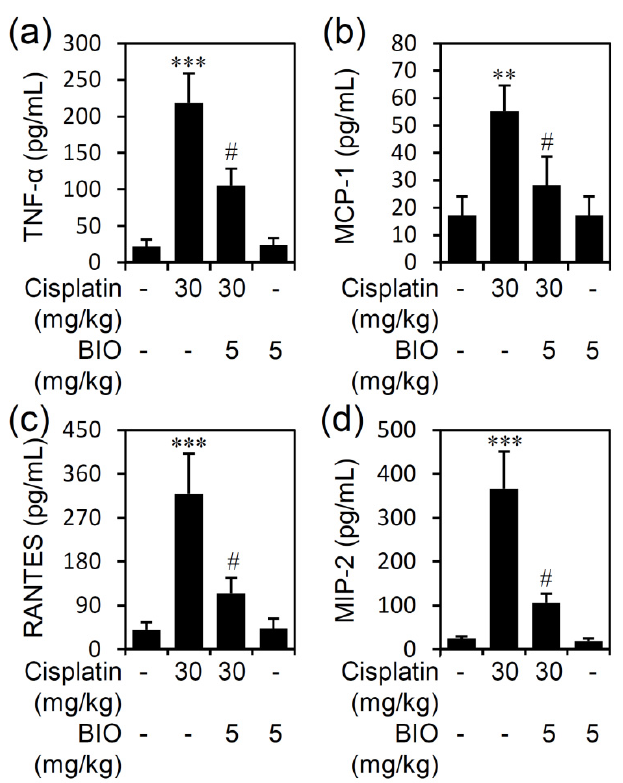
Figure 5. Inhibiting GSK-3 blocks cisplatin-induced proinflammatory cytokine/chemokine production. Male C57BL/6 mice ( n = 3) were preinjected i.p. with the GSK-3 inhibitor BIO (5 mg/kg) for 0.5 h followed by cisplatin (30 mg/kg) for 24 h. ELISA for ( a ) TNF- α , ( b ) MCP-1, ( c ) RANTES, and ( d ) MIP-2. Quantified data are the mean ± SD. ** p < 0.01 and *** p < 0.001 compared with untreated. # p < 0.05 compared with cisplatin.